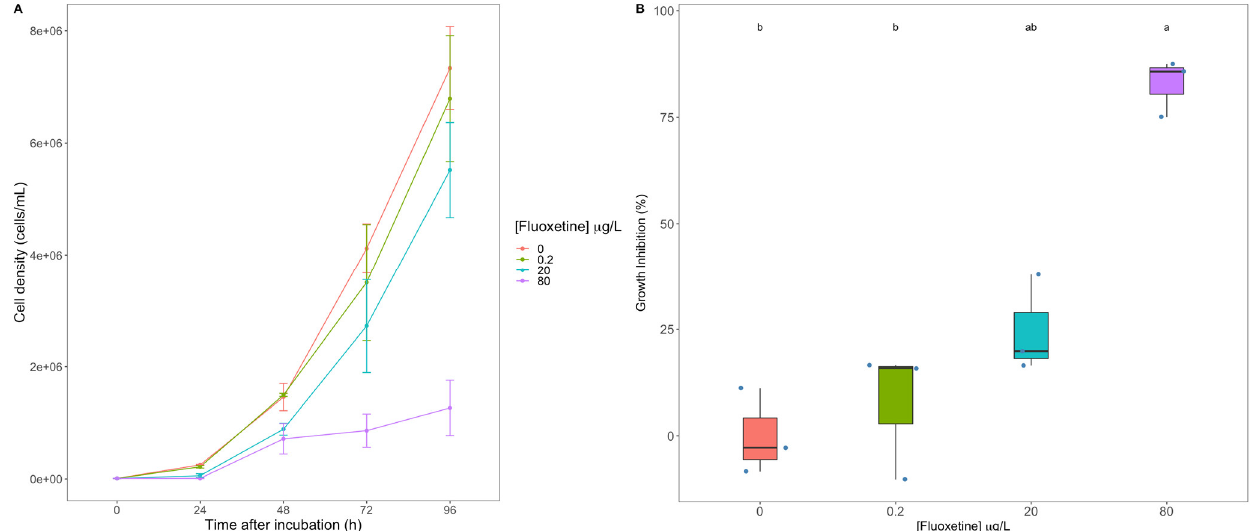
Figure 1. Growth curves (( A ), average ± standard error) and growth inhibition ( B ) observed in the diatom cultures exposed to 0, 0.2, 20 and 80 µg/L fluoxetine ( n = 3, different letters denote significant differences at p < 0.05).